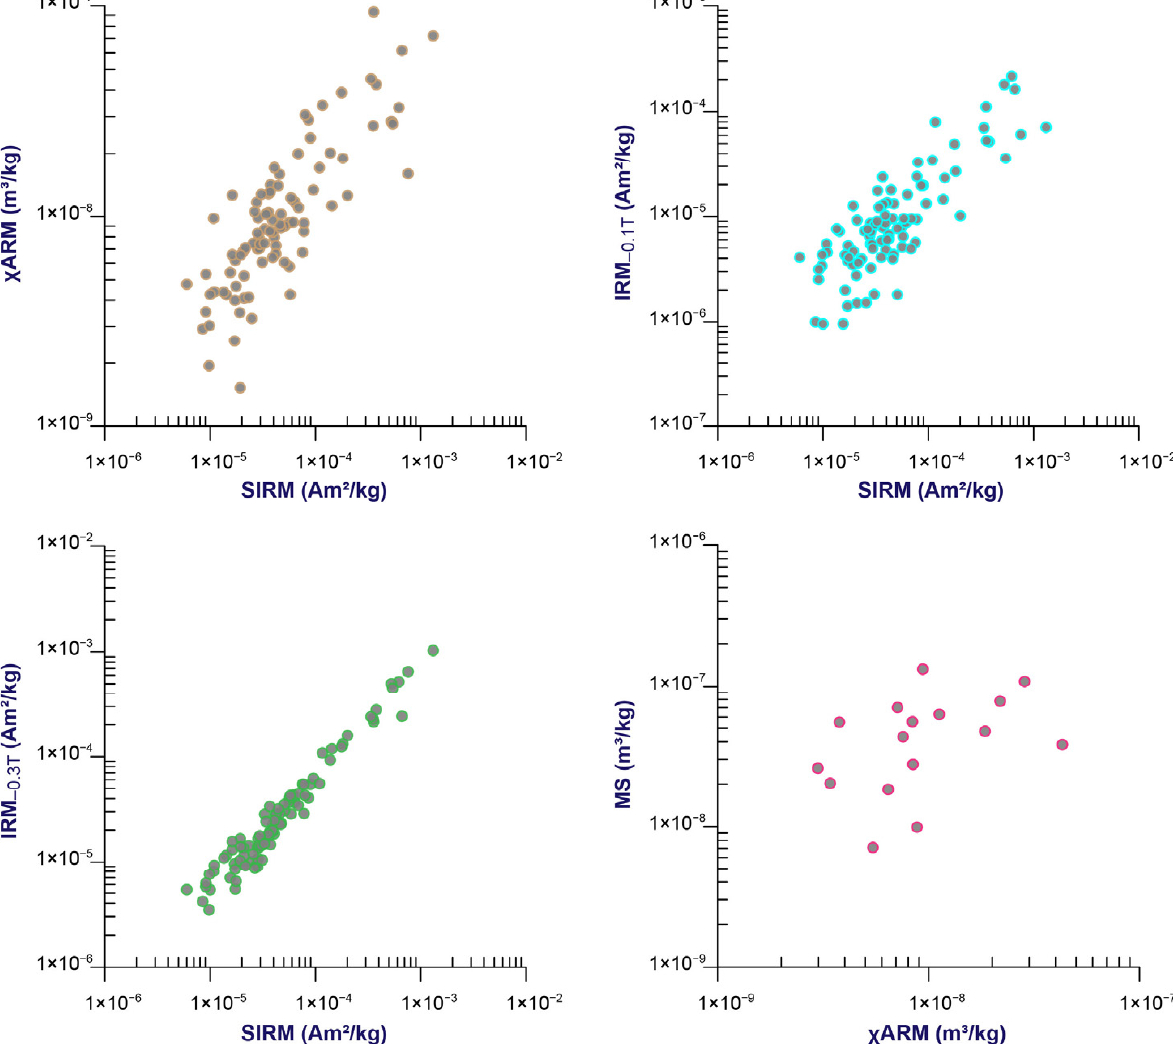
Figure 4. Relationship between the magnetic parameters of core XK-1.